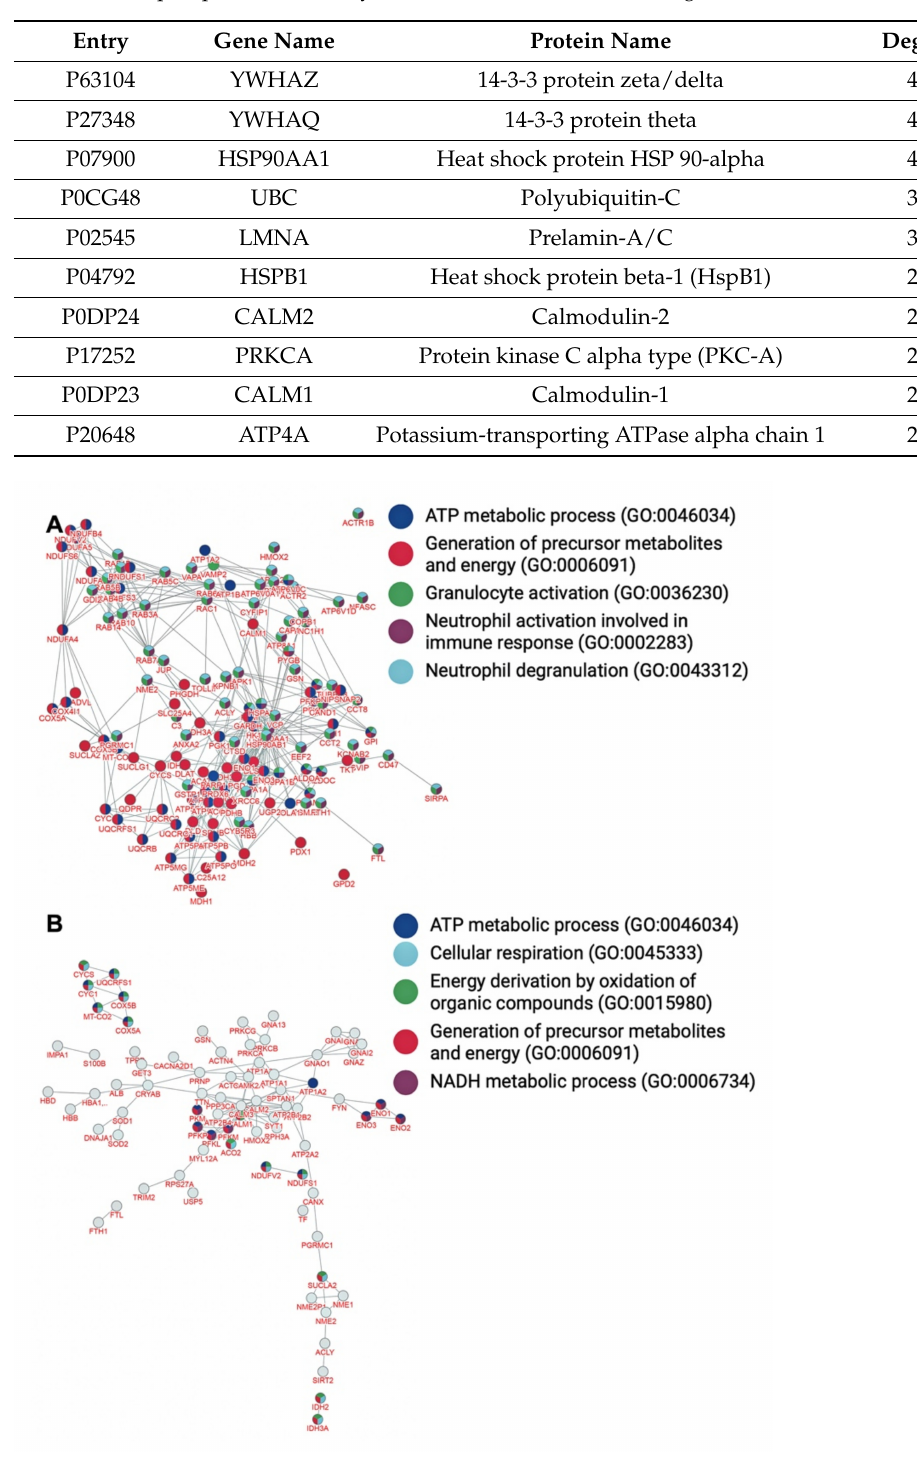
Table 2. The top 10 proteins in the myelin PPI network that have the largest number of interactions (>24).